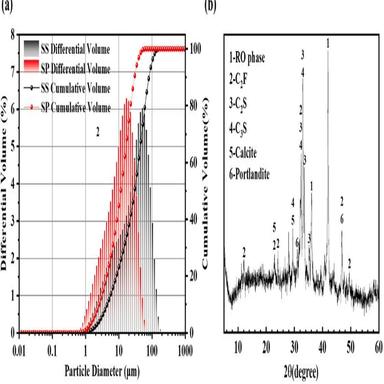
(a) The volume average particle size of SS and SP; (b) The XRD pattern of SS.